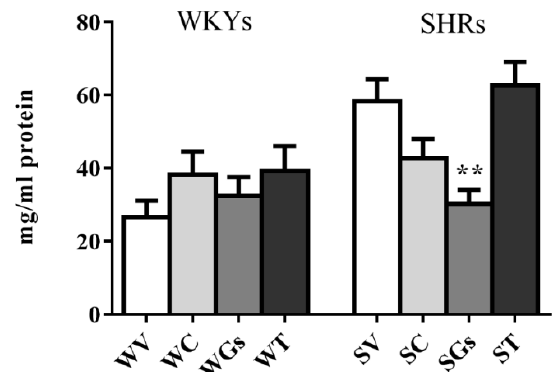
Figure 5. E ff ect of di ff erent treatments on TNF- α plasma content in SHRs and WKYs. Animals were Figure 5. Effect of different treatments on TNF ‐α plasma content in SHRs and WKYs. Animals were treated for 4 weeks with vehicle, captopril (50 mg / kg), tomatine (8 mg / kg) and gel / serum (Gs) (12.40 g / treated for 4 weeks with vehicle, captopril (50 mg/kg), tomatine (8 mg/kg) and gel/serum (Gs) (12.40 g/kg). Data are reported as mean ± SEM. ** p < 0.01 vs. SV (one ‐ way ANOVA followed by Bonferroni